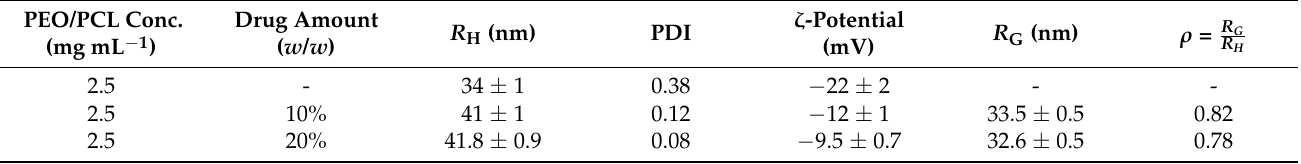
Table 4. Results for drug content evaluation using UV-Vis spectroscopy for PEO 113 - b -PCL 118 micelles with the best CIP concentrations. Total Polymer